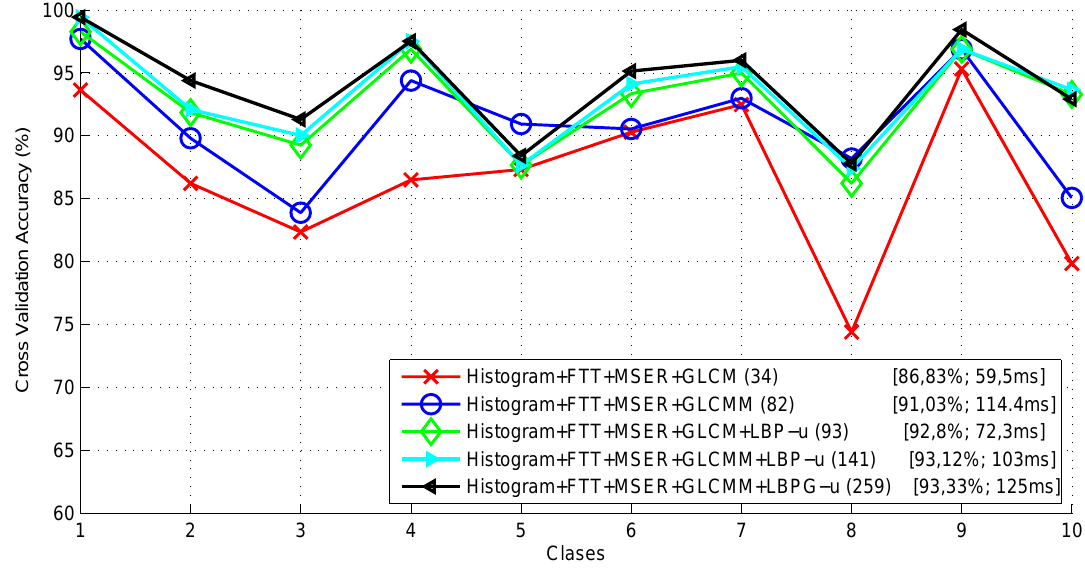
Figure 18. Cross validation accuracy (%) of different feature groups. The legend includes information about the vector dimension, average accuracy and computational cost.